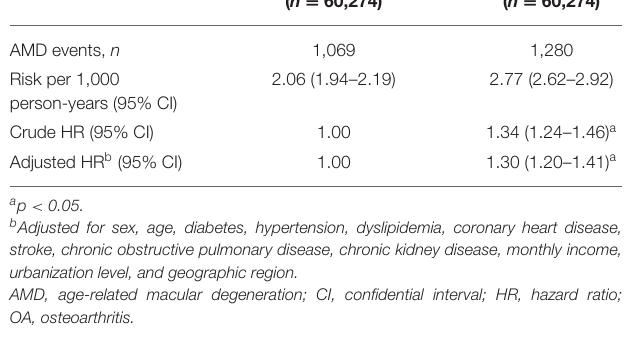
TABLE 2 | Number of age-related macular degeneration (AMD) events and hazard ratios (HRs) for the osteoarthritis (OA) and non-OA groups. Variable